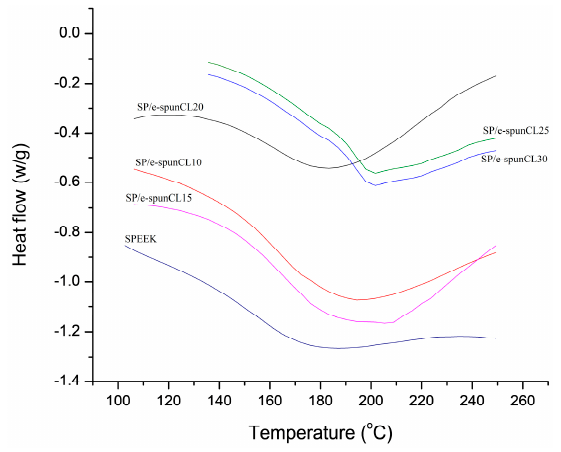
Figure 9. DSC curves reheating for SP/e-spunCL and SPEEK membranes.